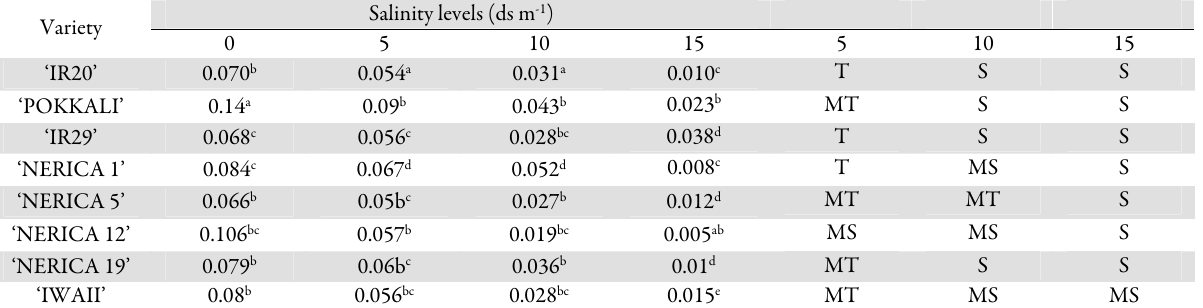
Tab. 6. Effect of salinity on total dry matter production (g/5 plants) of different rice varieties and their classification to salinity